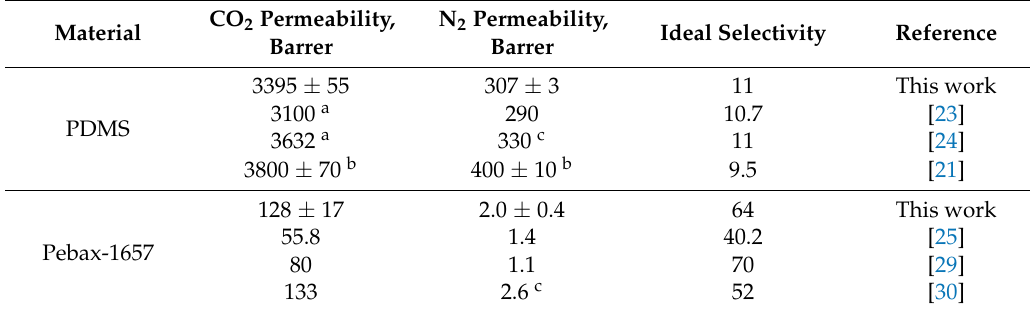
Table 1. CO 2 and N 2 permeabilities and CO 2 /N 2 selectivity of the bulk materials measured in this work compared to reported values in literature.